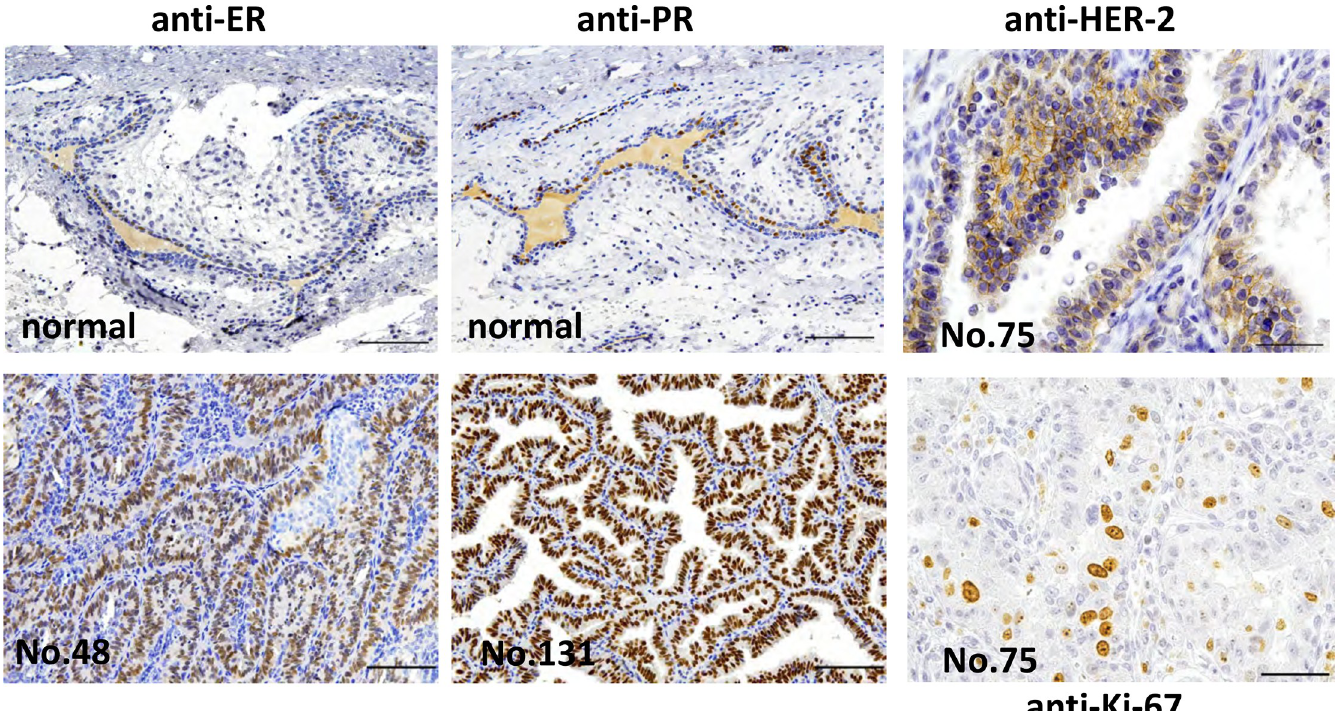
Fig 5. Immunohistochemistry staining of tree shrew mammary gland tumors with anti ER (tree shrew No. 48, 2 years 5 months old) and anti-PR (tree shrew No. 131, 3 years 7 months old) antibodies (bar = 100 μ m) (lower left and middle), and tree shrew tubulopapillary carcinomas with anti-HER-2 (tree shrew No.75: 6 years and 1 month old) (bar = 50 μ m lower; × 400) (upper right). More than 10% of the tumor cell membrane was stained partially or weakly but entirely (upper right). In normal tissues of the tree shrew mammary gland, the expression of ER and PR was observed in the nucleus of ductal epithelial cells (upper left and middle). Ki-67 + mammary tumor cells (tree shrew No.75, 6 years and 1 month old) are also shown (lower right; × 400).